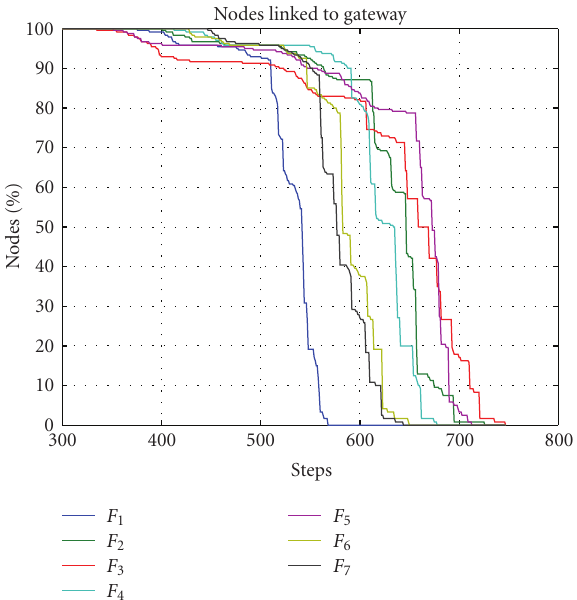
Figure 10: Percentage of nodes connected to gateway during iterations for di ff erent criteria, defined in Table 2 (average results over 10 trials).